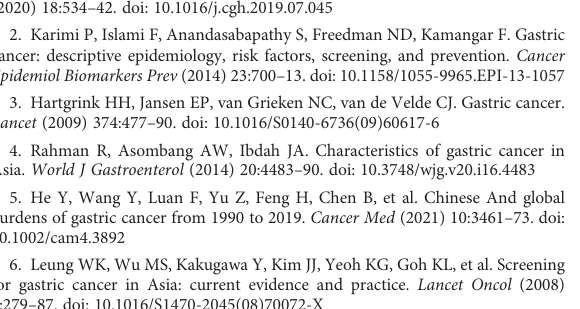
SUPPLEMENTARY FIGURE 12 Expression, prognosis and biological function analysis of LncRNA PVT1. (A, B) PVT1 is highly expressed in gastric cancer. (C) PVT1 is associated with T-stage of gastric cancer. (D) K-M curve showed that PVT1 was a protective factor for gastric cancer. (E) GSEA analysis of patients with high PVT1 expression. (F) GSEA analysis of patients with low PVT1 expression. (G1-8) Correlation between PVT1 and genes. (H, I) Go and KEGG enrichment analysis of PVT1.